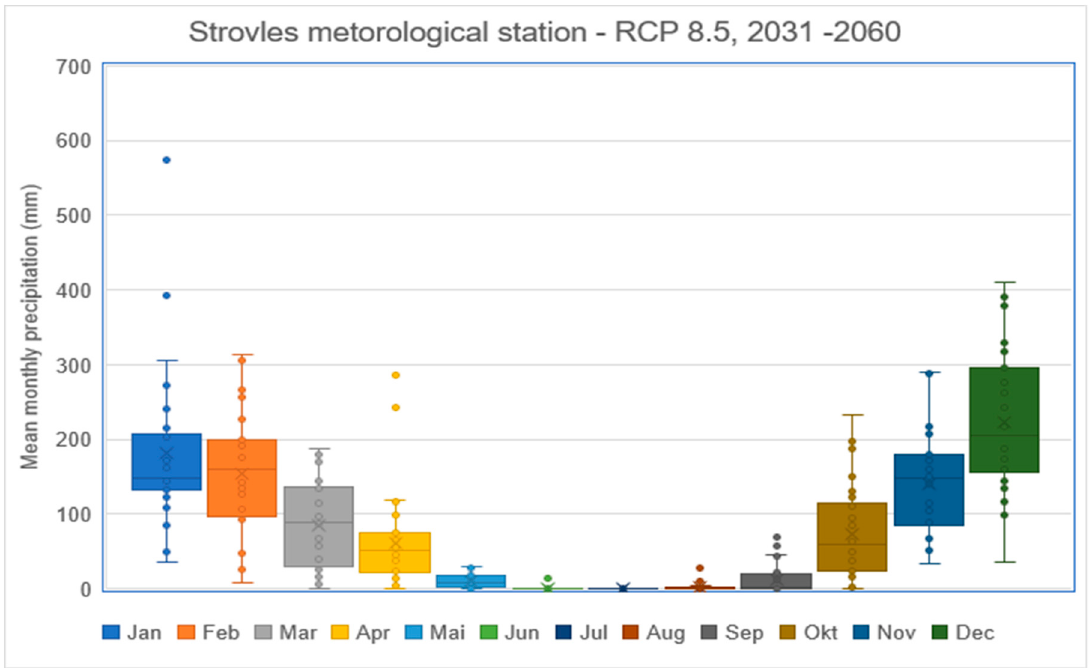
Figure 11. Average monthly precipitation for 2031–2060 according to RCP8.5 at the Strovles meteorological station.